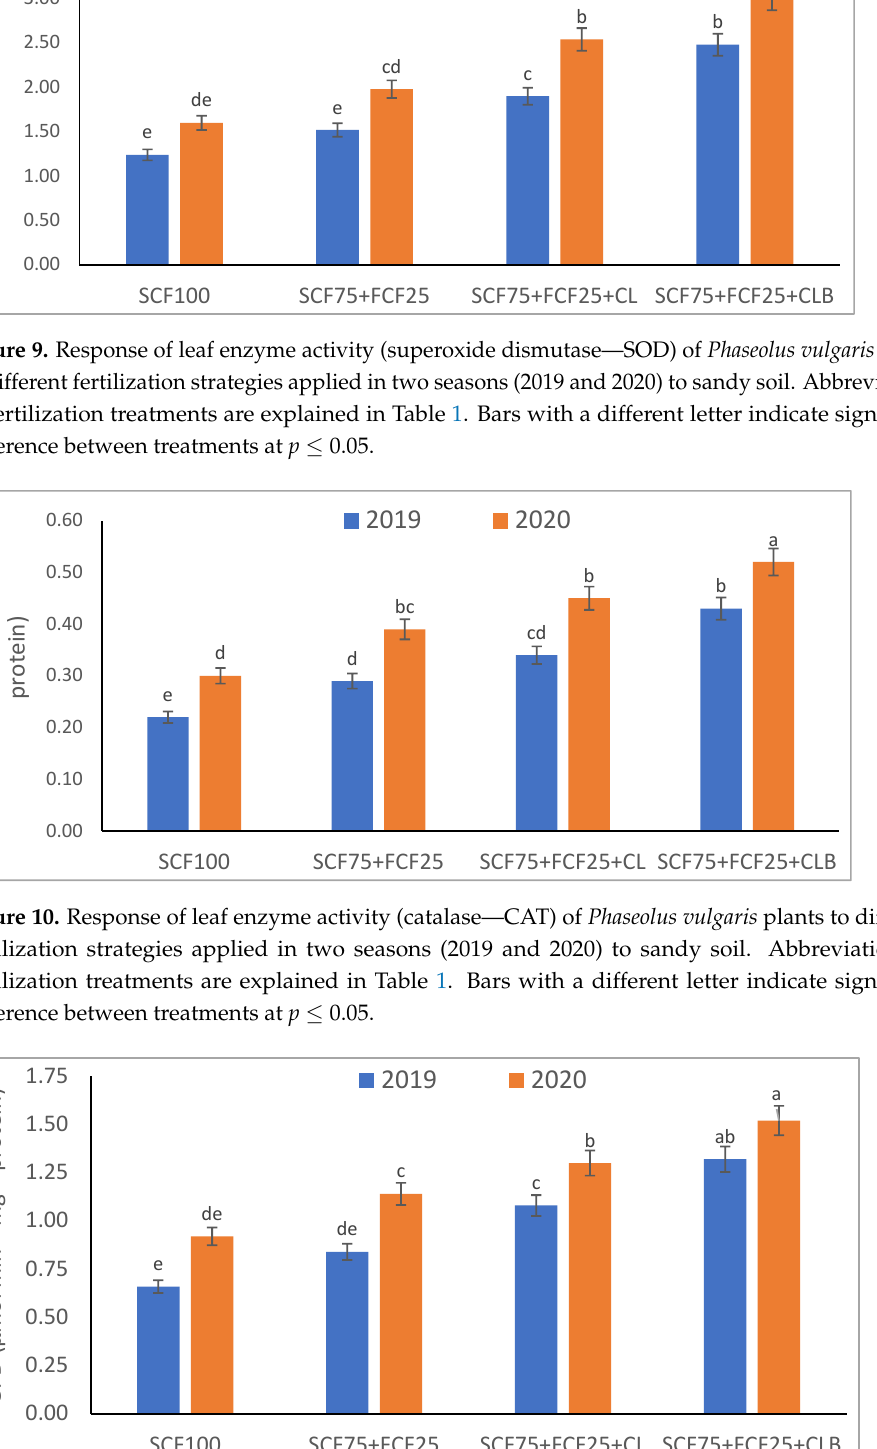
Figure 11. Response of leaf enzyme activity (guaiacol peroxidase—GPD) of Phaseolus vulgaris plants to different fertilization strategies applied in two seasons (2019 and 2020) to sandy soil. Abbreviations of fertilization treatments are explained in Table 1. Bars with a different letter indicate significant difference between treatments at p ≤